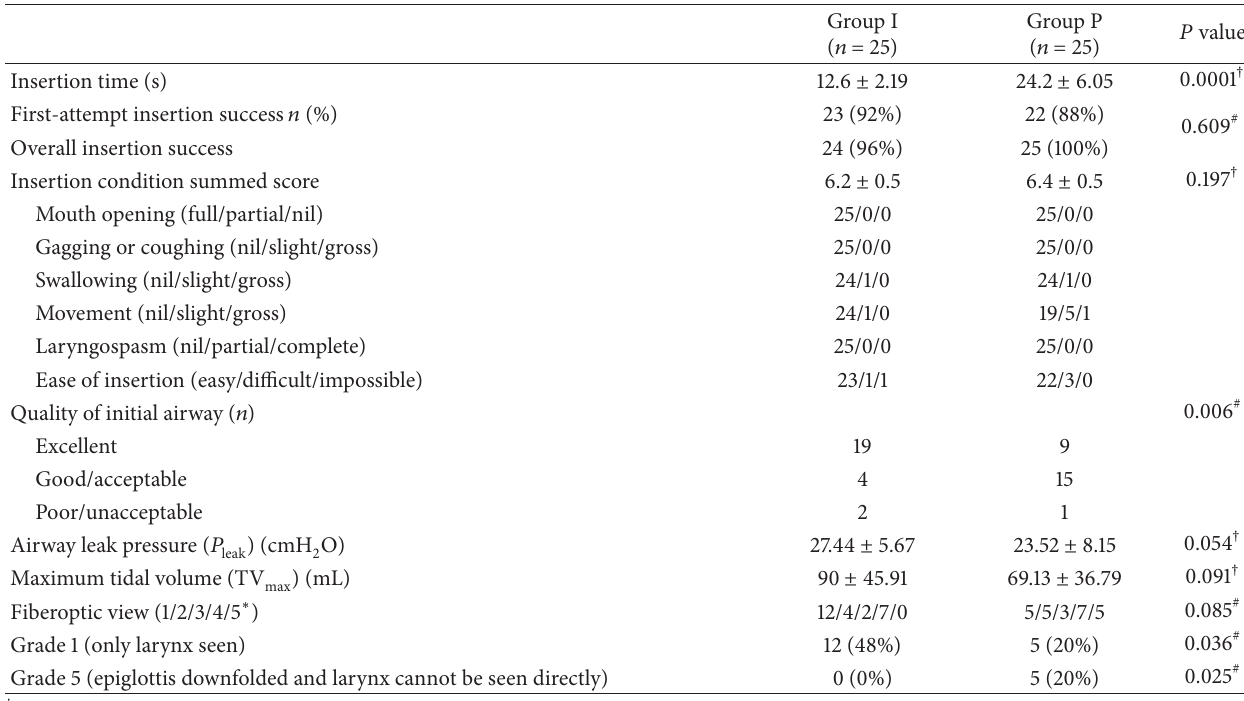
Table 2: Conditions during insertion, quality of initial airway, airway leak pressure, maximum tidal volume, and fiberoptic view of size 1 I-gel and PLMA and complications during surgery and emergence. Values are mean ± standard deviation or number (proportion).